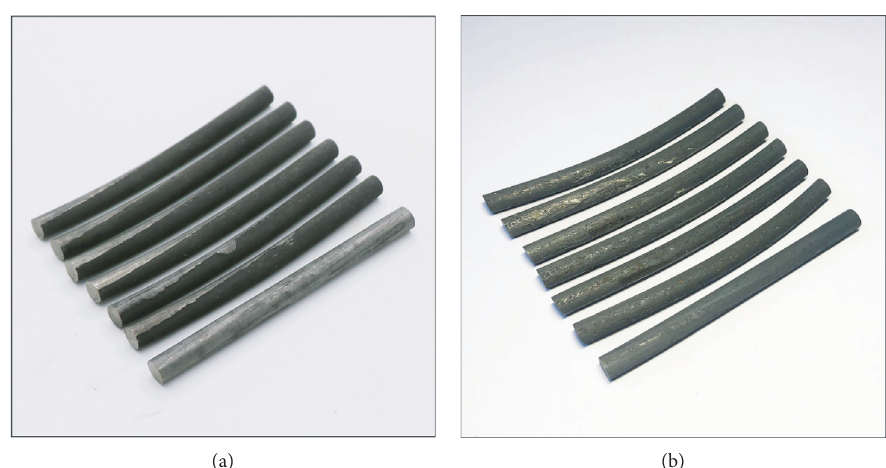
Figure 5: Morphology of anchor cable corroded samples. (a) Samples in electrolytic corrosion test; (b) samples from a power station.